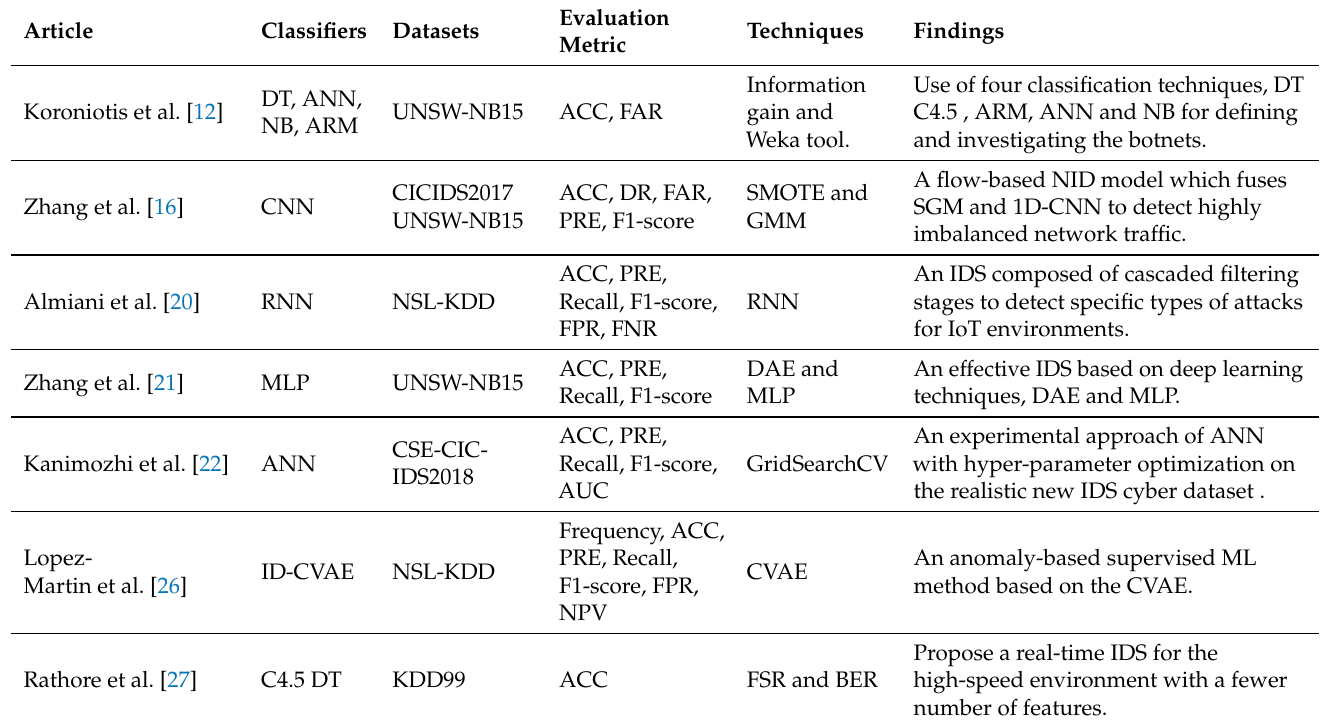
Table 1. Summary of the most relevant works in the